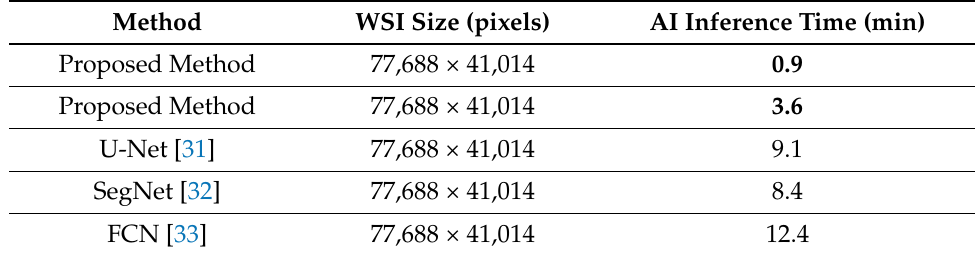
Table 4. Computational time comparison of the proposed method and the baseline